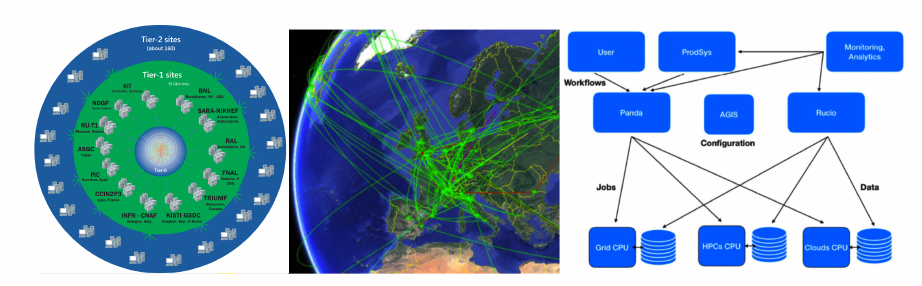
Figure 1: At left: the WLCG infrastructure which, across its Tier0, Tier1, and Tier2 centers, provided the bulk of the computing capacity for LHC Run 1 and Run 2 processing, storage, simulation and analysis. At right, distributed computing system components (in this case ATLAS [3]) which are typical of the LHC